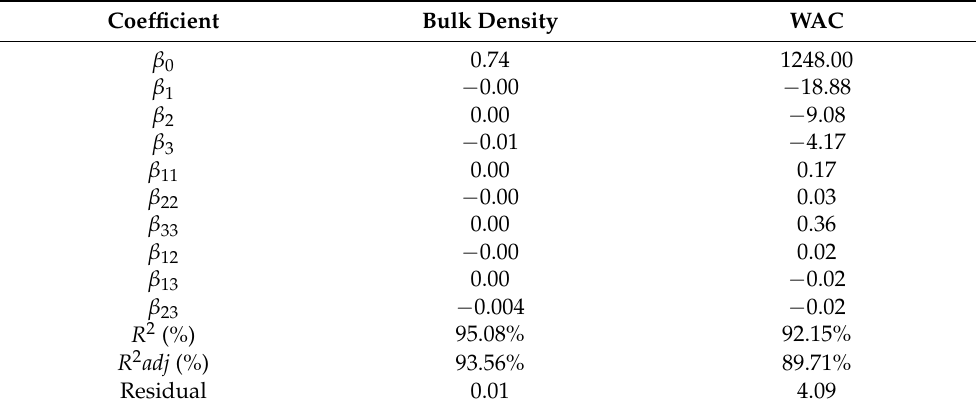
Table 3. Coefficient of regression for the different mathematical models obtained. Coefficient Bulk Density WAC β 0 0.74